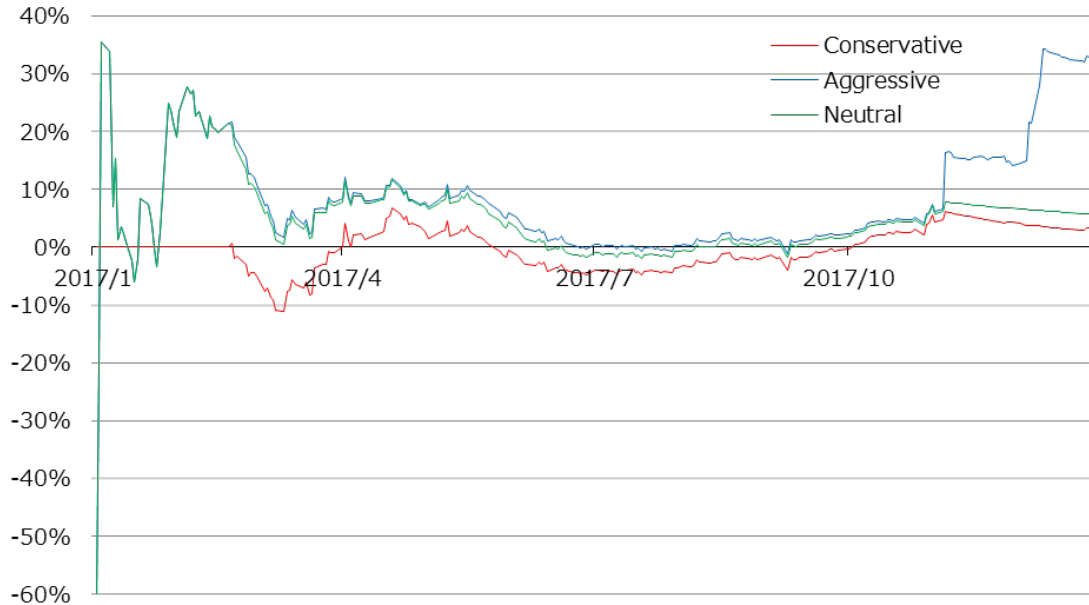
Table 4. Simulation results.